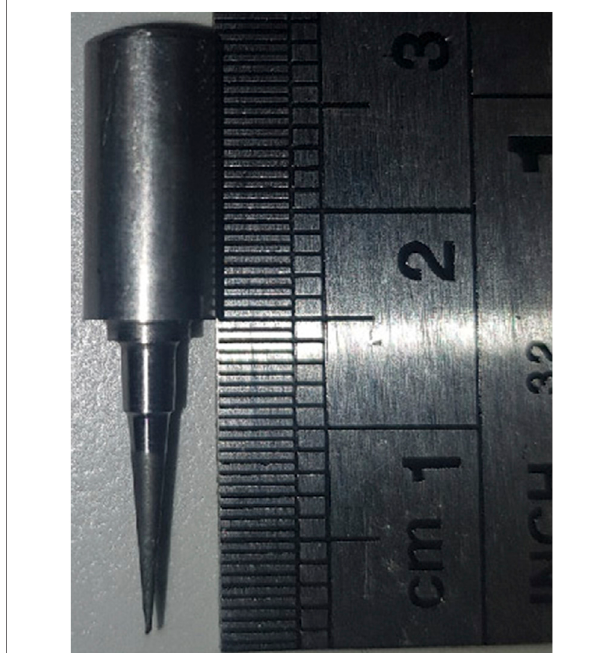
FIGURE4| Conicalindentationtipwithaninternalangleof9.5 o andatip radius of 250 μ